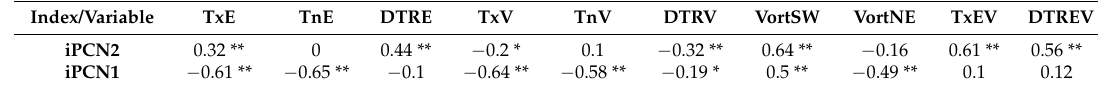
Table 2. Linear Correlations (1948–2006).